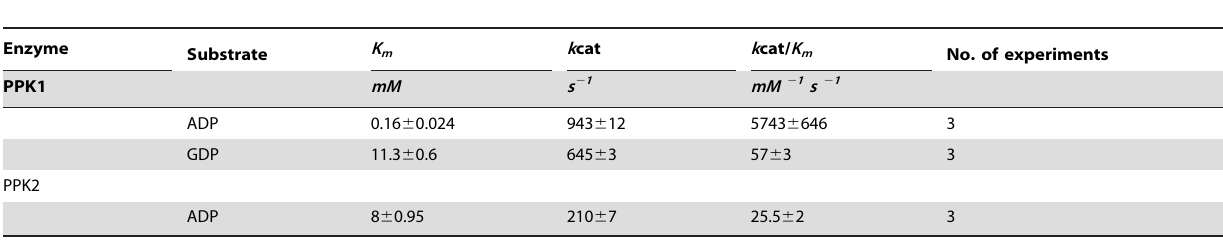
Table 2. Kinetics for NTP synthesizing activities by PPK1 and PPK2 from M. tuberculosis .